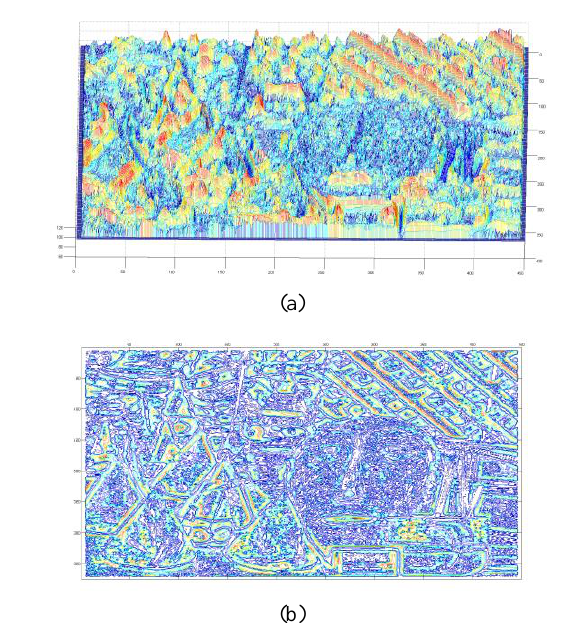
Figure 3.Display of the RBI space. (a) Cones in the 3D RBI space. (b) The contour of Cones in the RBI